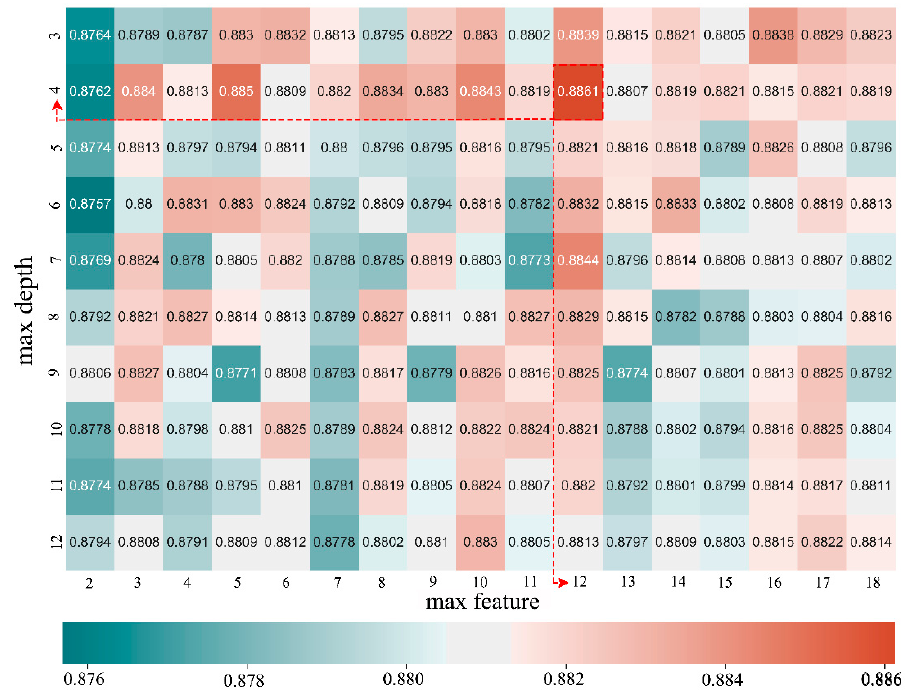
Figure 3. The ten-fold cross validation for the proper parameters in the random forest.